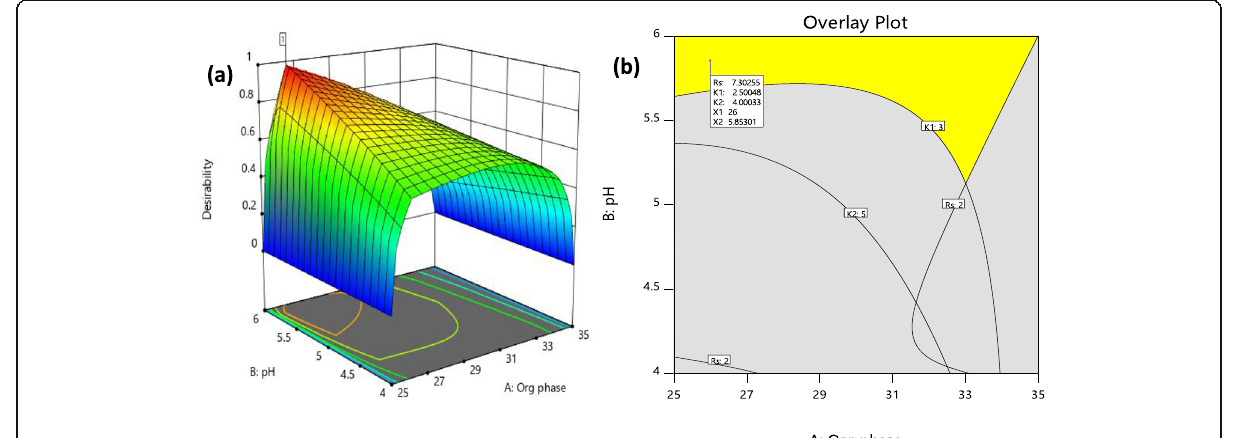
Fig. 2 Design space: ( a ) numerical optimization — desirability study (3D plot); ( b ) graphical optimization-overlay plot